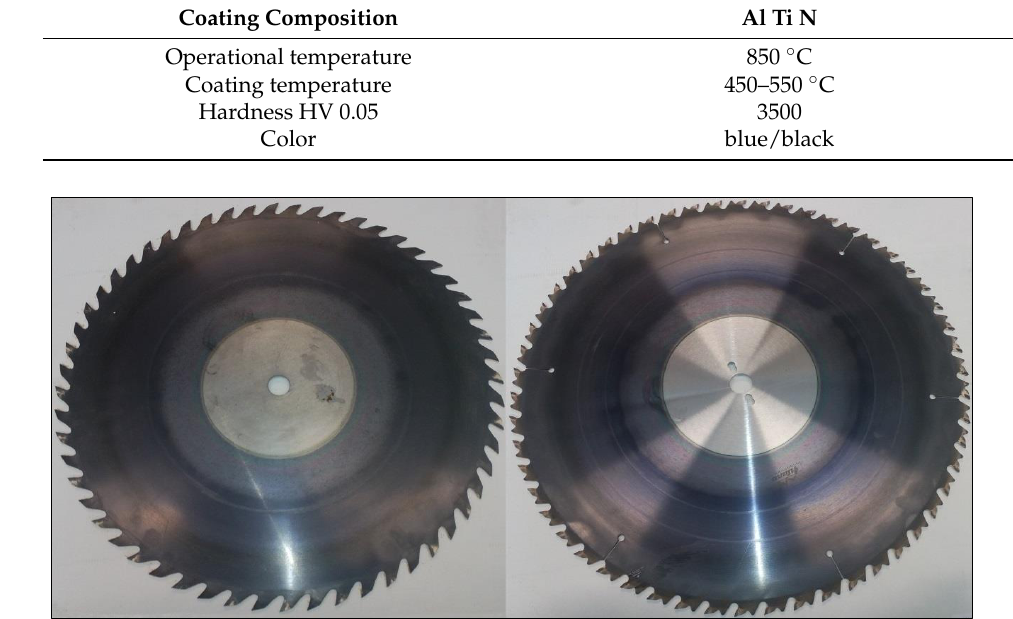
Table 1. Technical parameters of Maximizer AlTiN coating (www.ionbond.com, accessed on 10 October 2018).